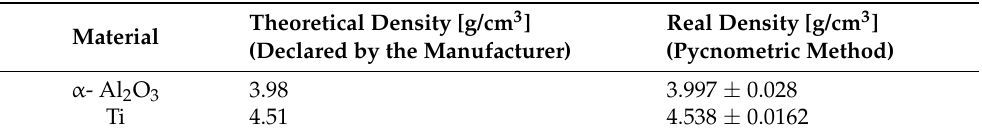
Table 2. Theoretical densities of alumina, nickel and titanium oxide powder declared by manufacturers and actual densities measured by the pycnometric method.